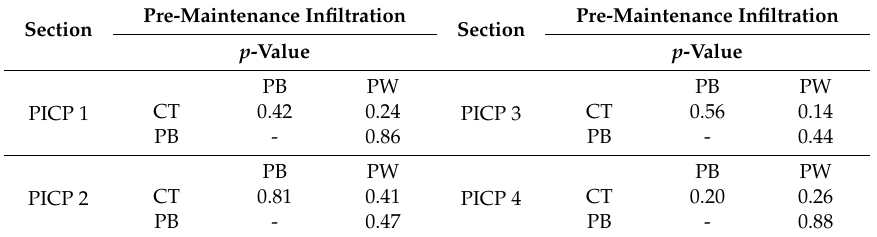
Table 6. Significance of difference for two-sided generalized Wilcoxon test between each subsection.